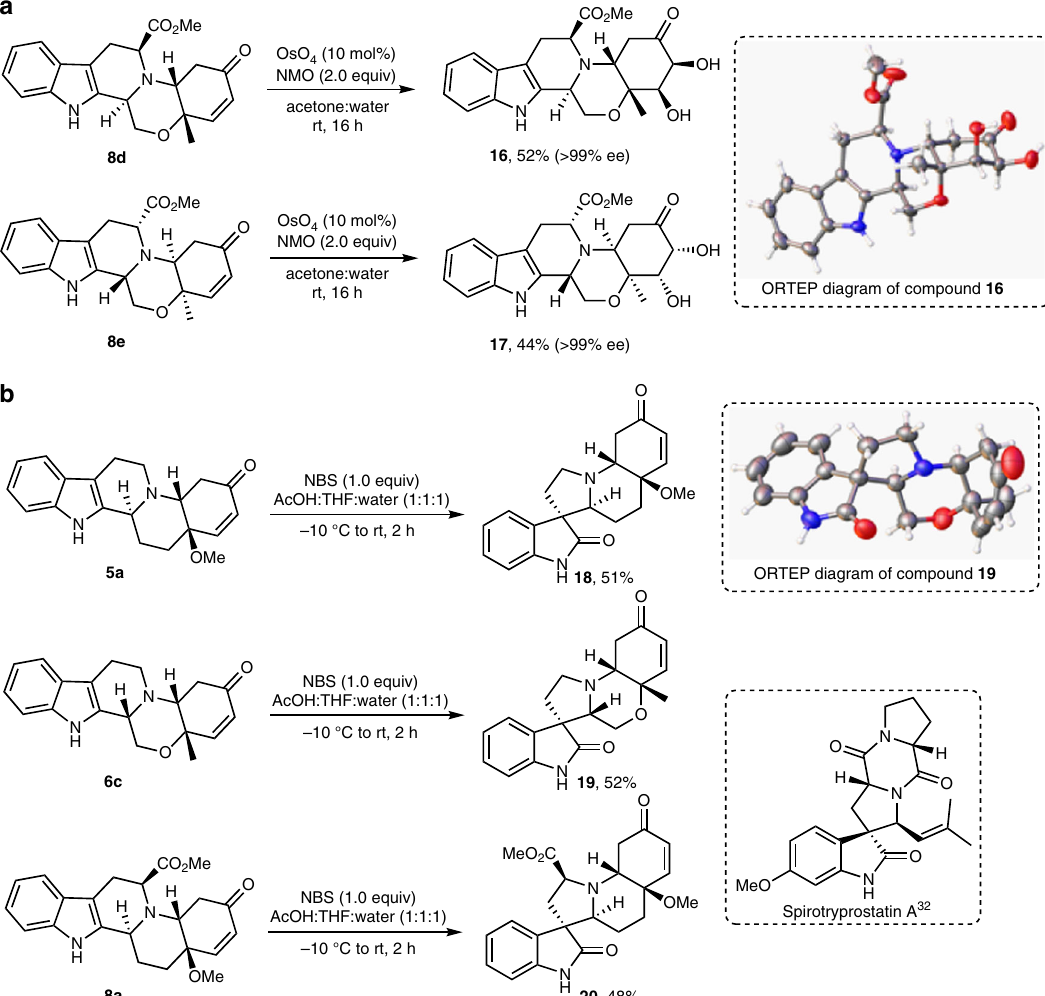
Fig. 6 Post-pairing transformations of octahydroindolo[2,3-a]quinolizines. a OsO 4 -catalyzed dihydroxylation. b NBS-mediated synthesis of spiro-oxindole polycyclic systems. AcOH acetic acid, THF tetrahydrofuran NATURE COMMUNICATIONS| (2018) 9:4989 |DOI: